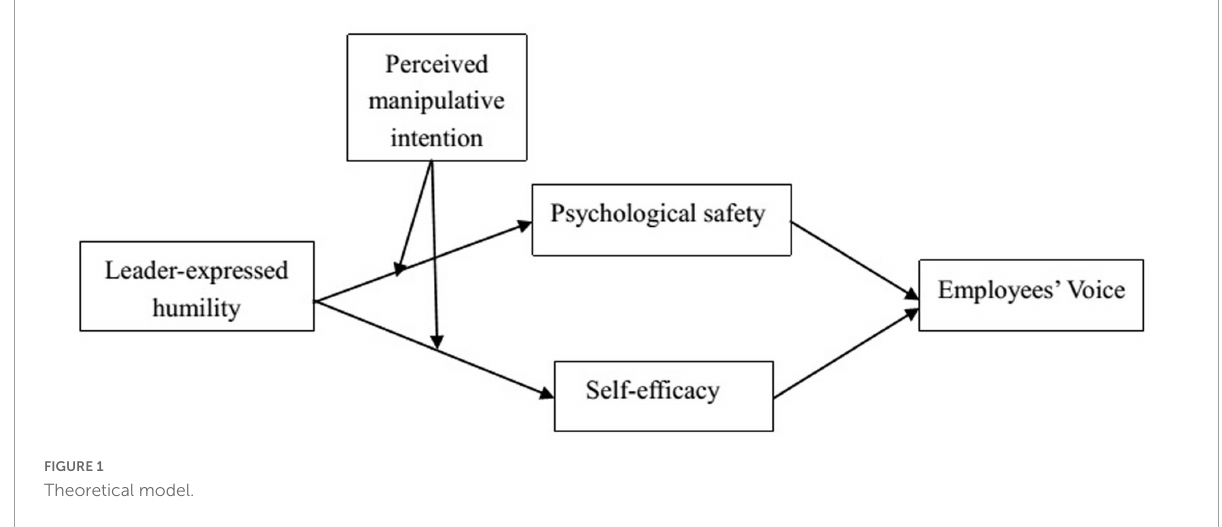
FIGURE1 Theoretical